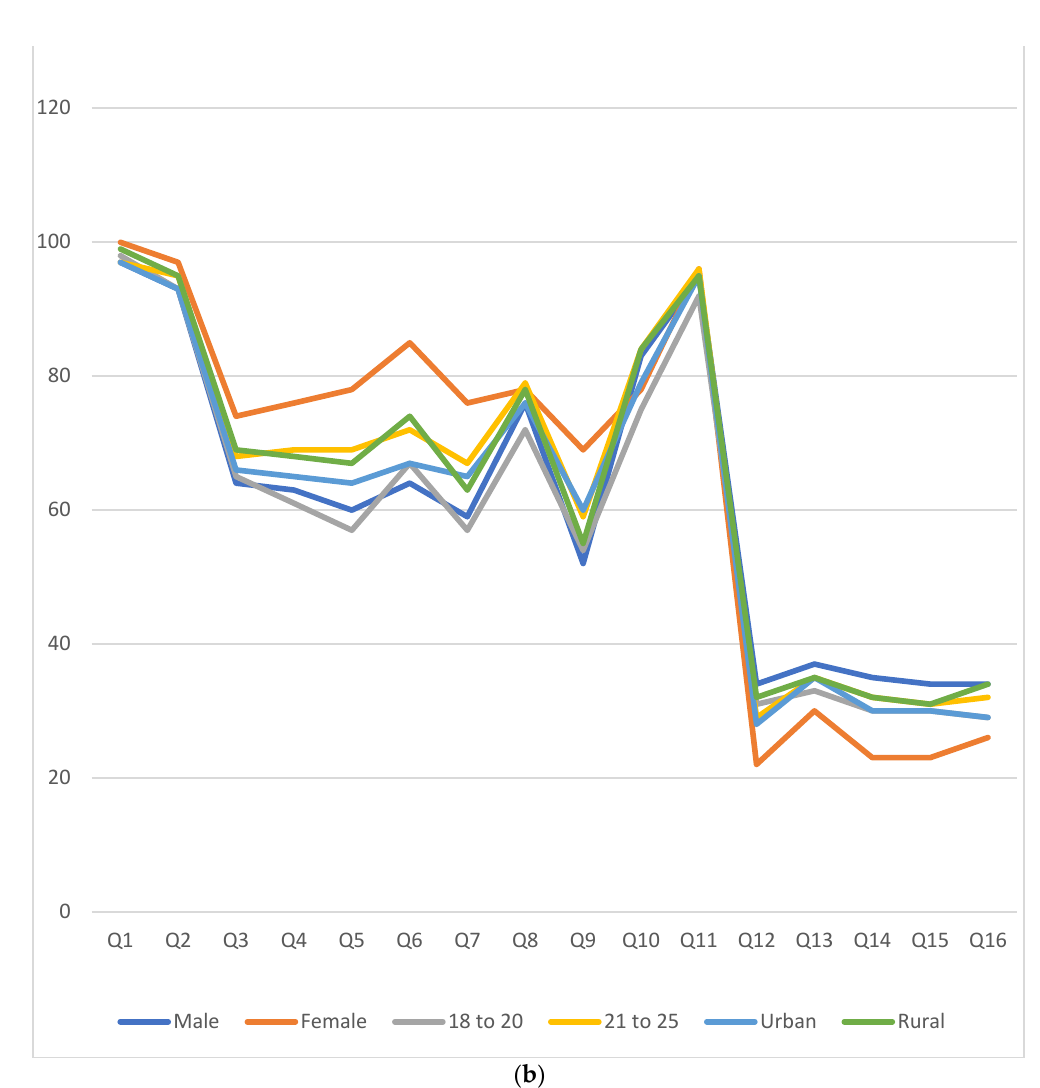
Figure 2. ( a ) Responses of the participants are depicted as stack bars in numbers. Four bars belong to each question. Responses as ‘yes’ are shown in the first and third bars from male and female participants, respectively. Similarly, the second and fourth bars represent a ‘no’ response. ( b ) Positive responses in percentage from various gender, age groups, and places of residence.